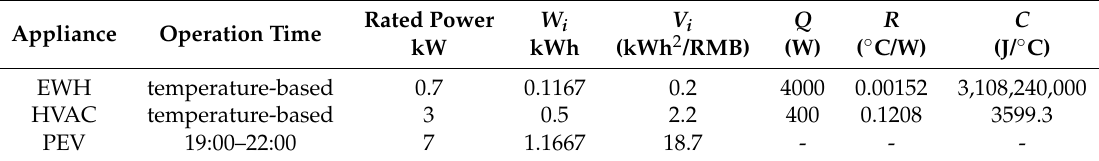
Table 2. Simulation parameters of controllable